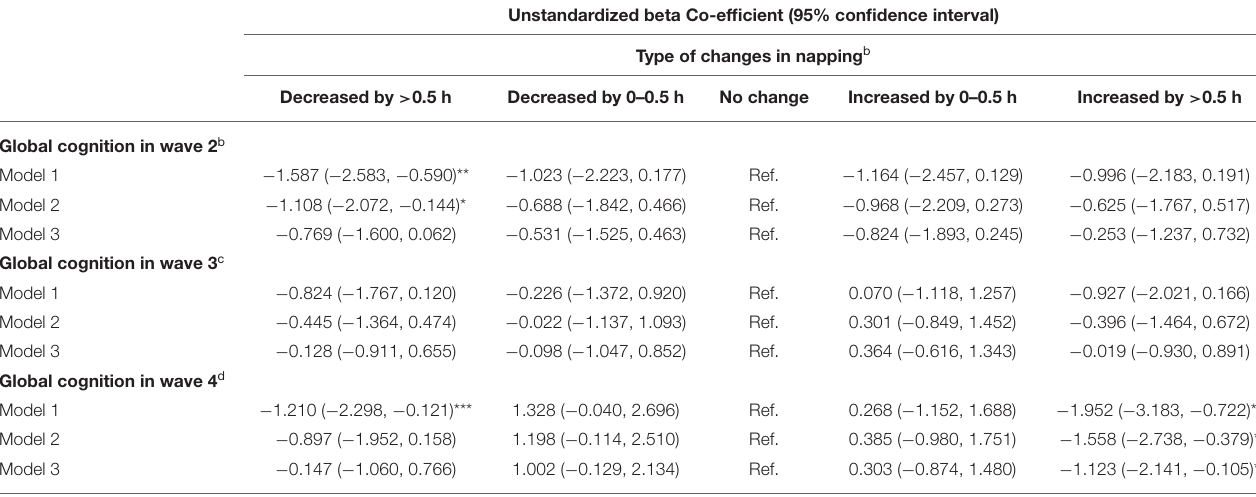
TABLE 4 | Associations between changes in daytime napping and global cognition among participants whose napping durations were 30–90min at baseline a . Unstandardized beta Co-efficient (95% confidence interval)